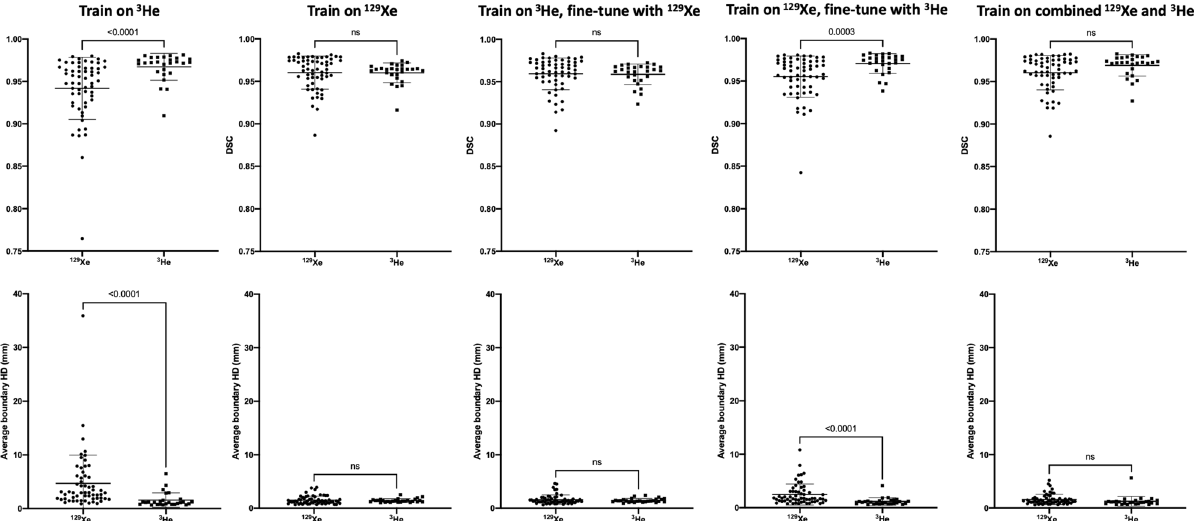
Figure 4. Comparison of DSC (top) and Avg HD (bottom) values for 129 Xe and 3 He testing scans for five DL methods. P-values between 129 Xe and 3 He using Mann–Whitney tests are shown. Mean and standard deviation values are marked by a bold line and whiskers, respectively.